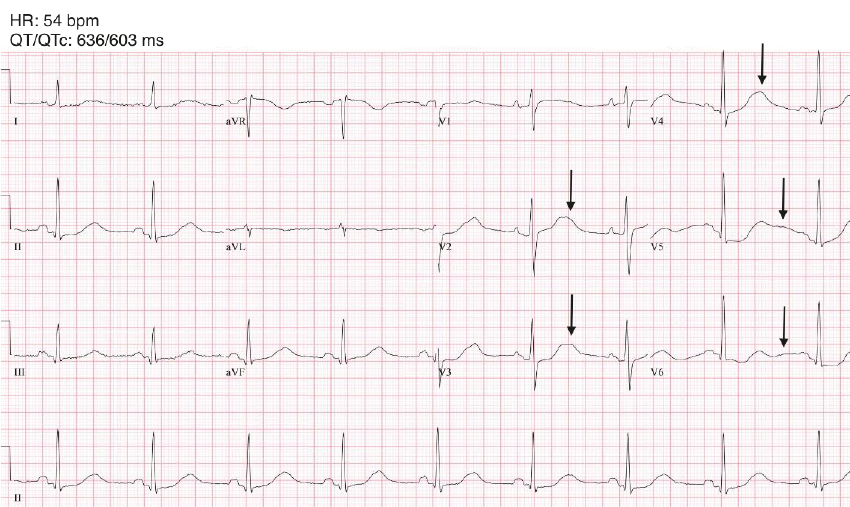
Figure 1: Electrocardiogram performed on first visit. The U waves are seen in precordial derivations (arrows). In V2-V3-V4, they are fused to the end of the T waves. In V5-V6, inverted T waves are followed by subtle U waves. The pseudo-prolonged QT interval actually results from the measurement of a long QU interval. HR = heart rate; bpm = beats per minute; QT = QT interval; QTc = corrected QT interval; ms = milliseconds.